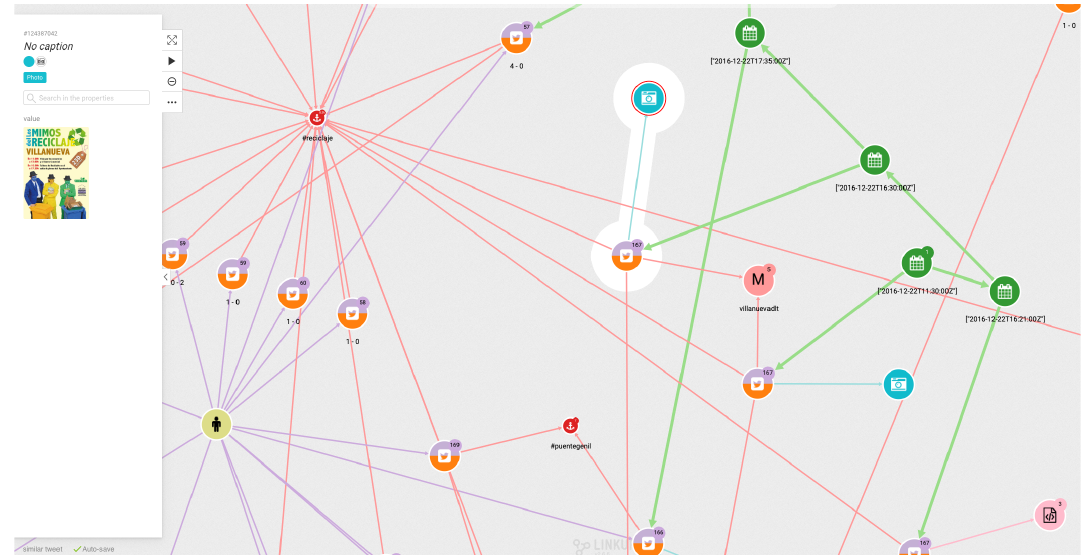
Figure 7. More elements for the analysis of the tweets